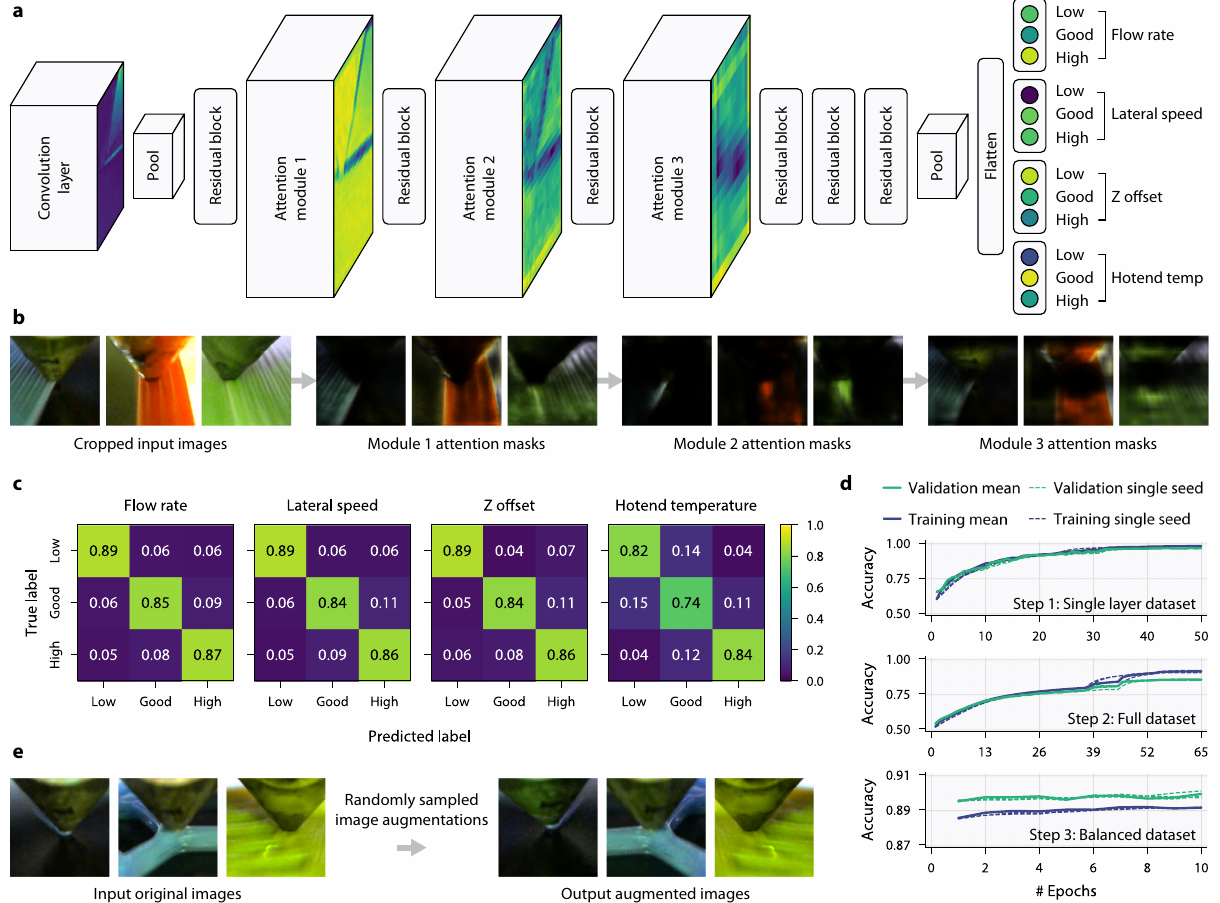
Fig. 2 | Multi-head residual attention network architecture, performance, and visualisations for human interpretation. a The multi-head network architecture consistofasinglesharedAttention-56network 58 backbone,whichcontainsstacked attention modules and residual blocks, followed by four separate fully connected outputheadsafterthe fl atteninglayer,oneforeachparameter.Eachoftheseheads classi fi es its associated parameter as either low, good, or high. Attention modules consist of a trunk branch containing residual blocks and a mask branch which performs down- and up-sampling. b Example attention masks at each module for